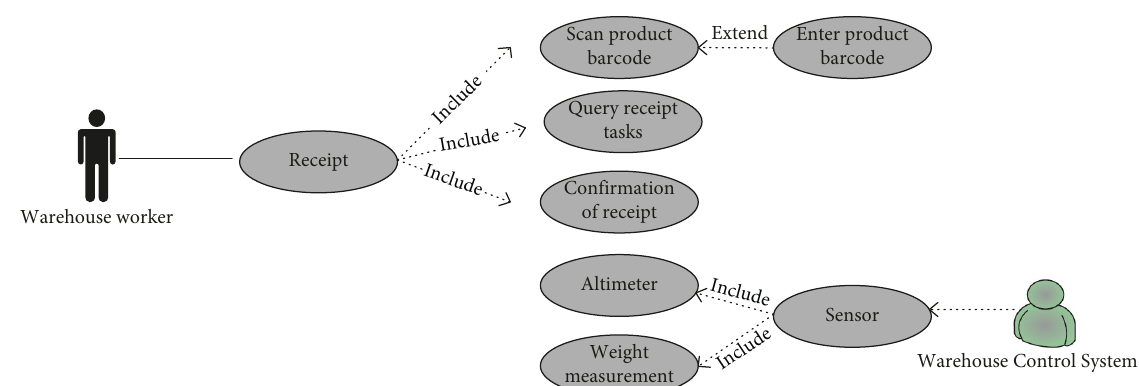
Figure 4: Receipt use case